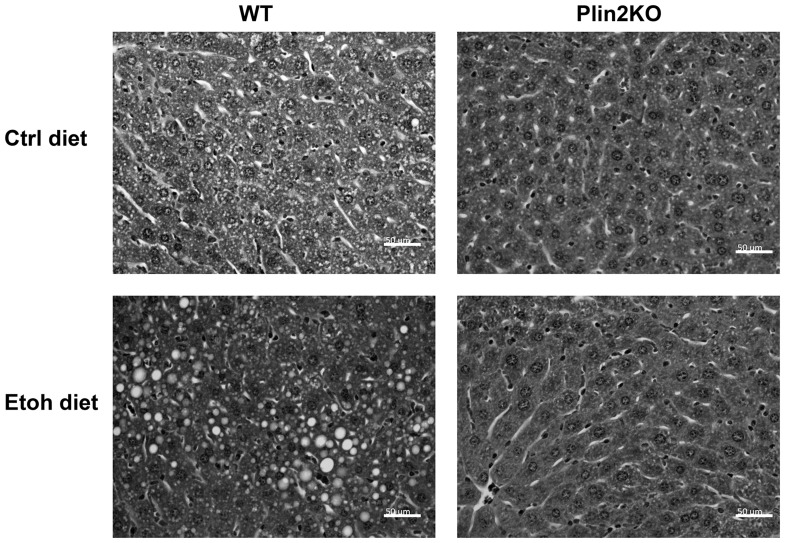
Liver histology of wild-type and Plin2KO mice fed control liquid or ethanol diet for 6 weeks.Representative hematoxylin and eosin-stained liver sections. 40x magnification. WT = wildtype KO = Plin2KO Ctrl = control Etoh = ethanol